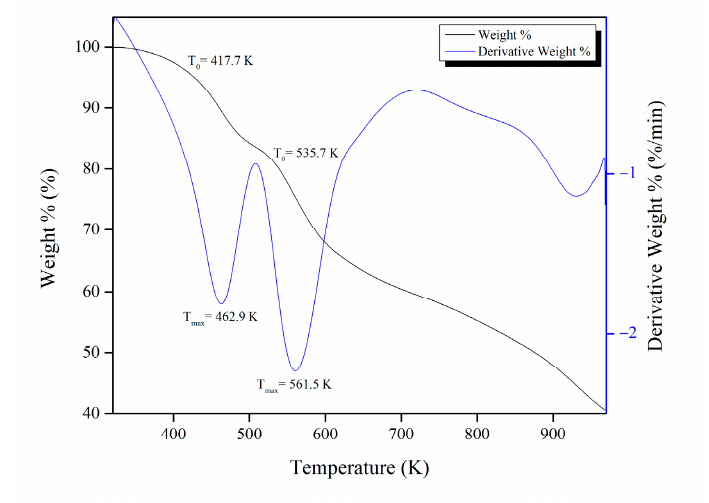
Figure 4. TGA curve of Mg-gallate.